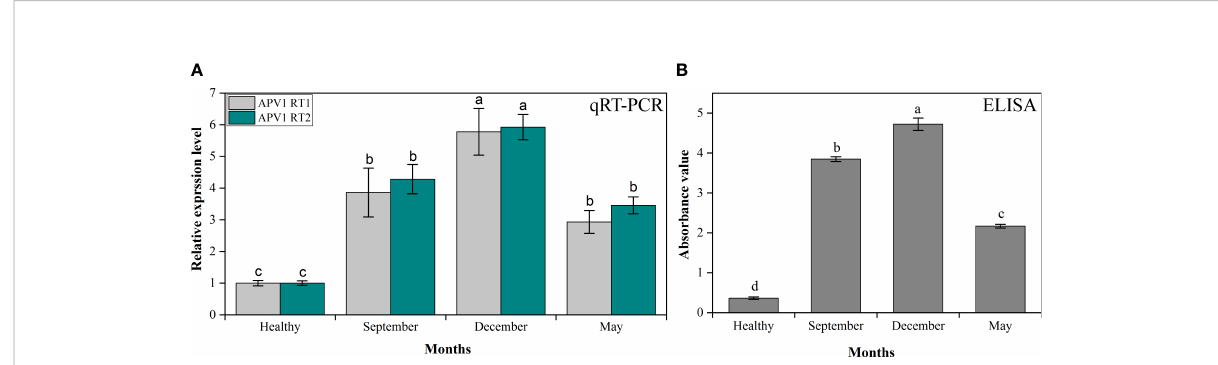
FIGURE 3 The APV1 titer accumulation analysis by (A) qRT-PCR in control (healthy), autumn (September), winter (December), and summer (May) seasons. The primer APV1-RT1 that encodes APV1-ORF9, and APV1-RT2 that encodes APV1-ORF7 were used for gene expression analysis. (B) The APV1 titer was detected by ELISA using a polyclonal antibody against APV1 coat protein. The absorbance values of APV1-positive seedlings in different seasons under natural environmental conditions were taken at OD 450 nm using a microplate reader (BioTek Synergy H1, USA). The results were calculated according to the formula [cutoff value (P/N) = (sample OD − blank OD)/(negative OD − blank OD)]. A mean absorption value of the tested samples twice higher than that of healthy plant antigen was taken as positive for the disease. Positive controls are the mean of absorbance readings of wells containing APV1-infected areca palm leaf samples, while negative controls are the mean of absorbance readings of healthy areca palm leaves. Data presented as means ± standard error, n = 9; signi fi cant differences are exhibited by lowercase letters ( p ≤ 0.05), according to the LSD test.